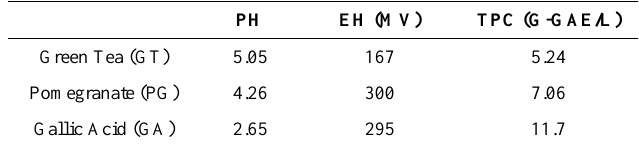
Table 1. Physicochemical properties of plant extracts and Gallic acid